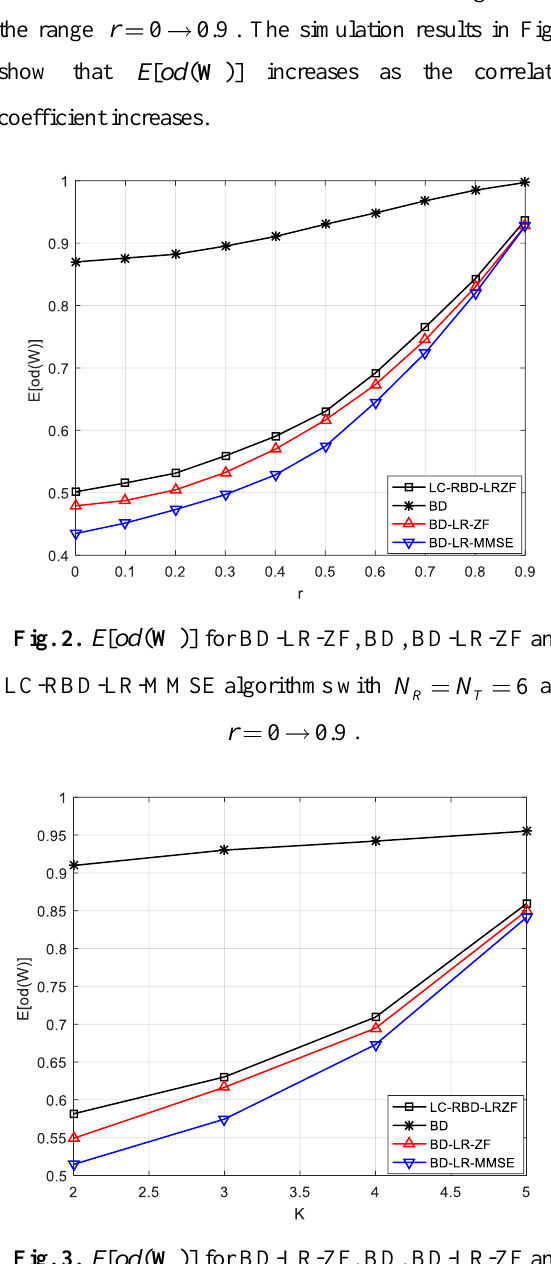
Fig. 3 illustrates the curves of as functions of K for all algorithms at SNR = 27 dB, và K = 2, 3, 4, 5. It can be observed from Fig. 3 that increases in an exponential manner with respect to K , i.e., with respect to the system size. More importantly, we can see from both figures that both BD-LR-MMSE and LC-RBD-LR-ZF precoders always have smaller than the remaining precoders. This